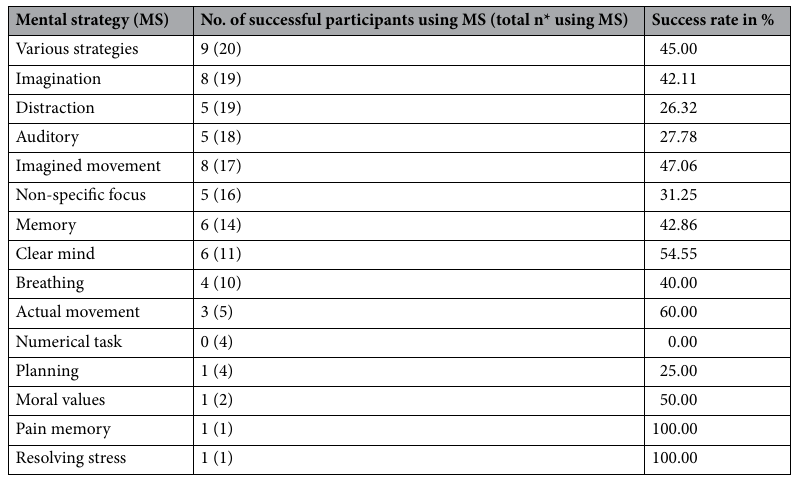
Table 4. The success rates of each Mental Strategy (MS) and the number of successful participants that used that strategy; ordered from most used to least used. *n = no. of participants.